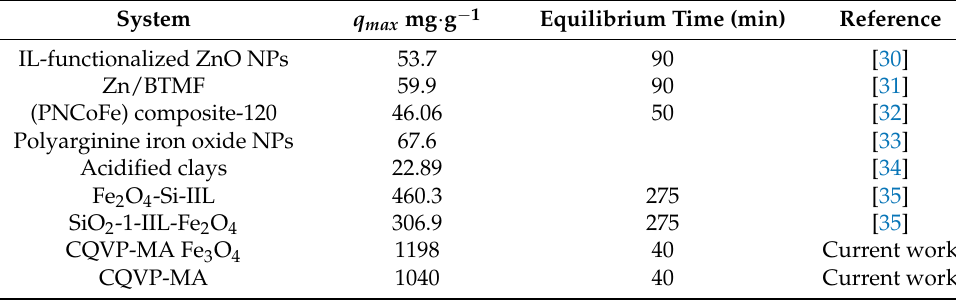
Table 2. Comparison of the adsorption capacities of various adsorbents for CBB at 25 ◦ C.